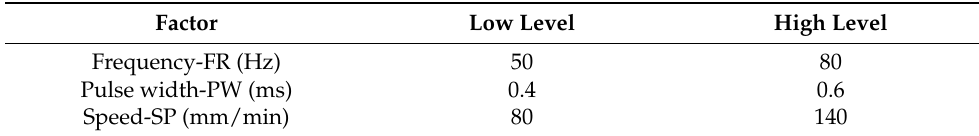
Table 2. Levels for the different variables.